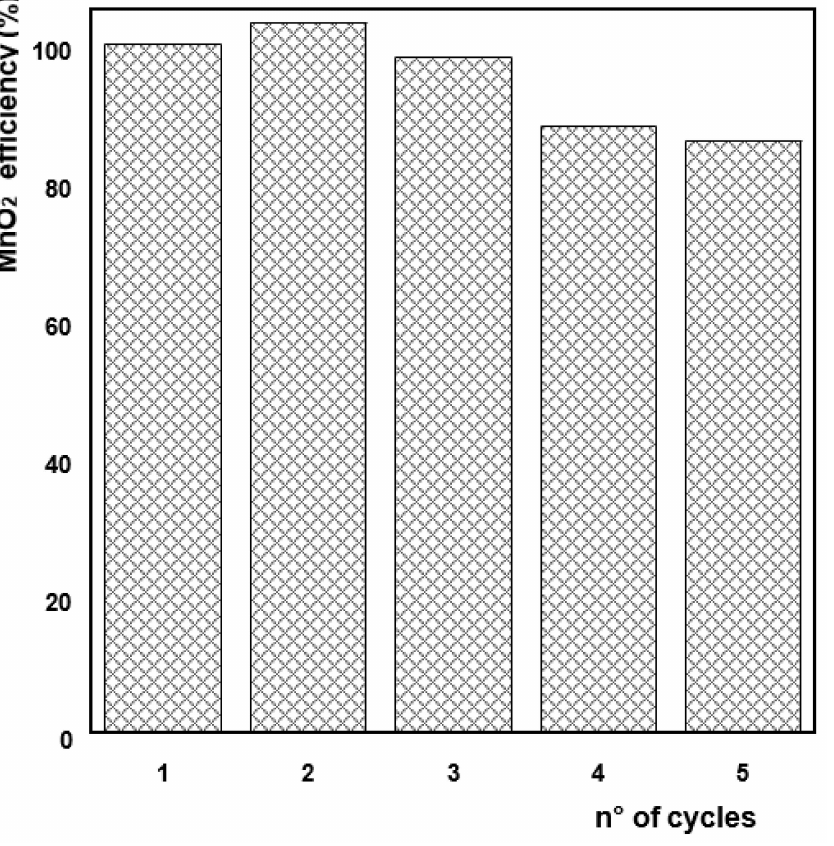
Figure 13. MnO 2 efficiency (%) in five consecutive